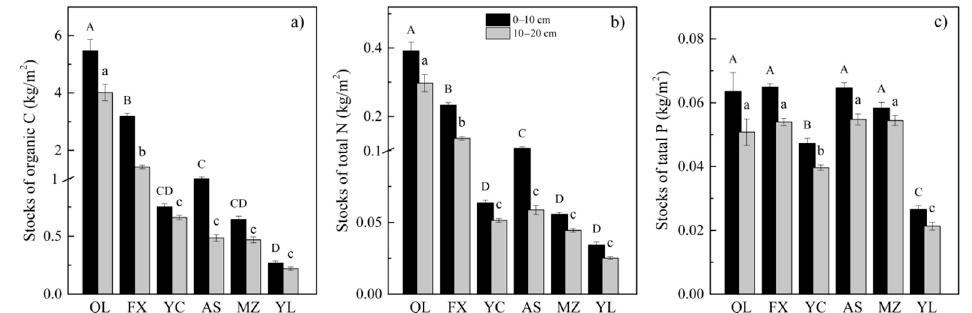
Figure 3. Variations of the stocks of soil organic carbon ( a ), total nitrogen ( b ), and phosphorus ( c ) at different sites along the rainfall gradient. Values are means ± standard error. Different uppercase letters and lowercase letters indicate significant differences ( p < 0.05) at 0–10 and 10–20 cm, respectively; this is the same below.